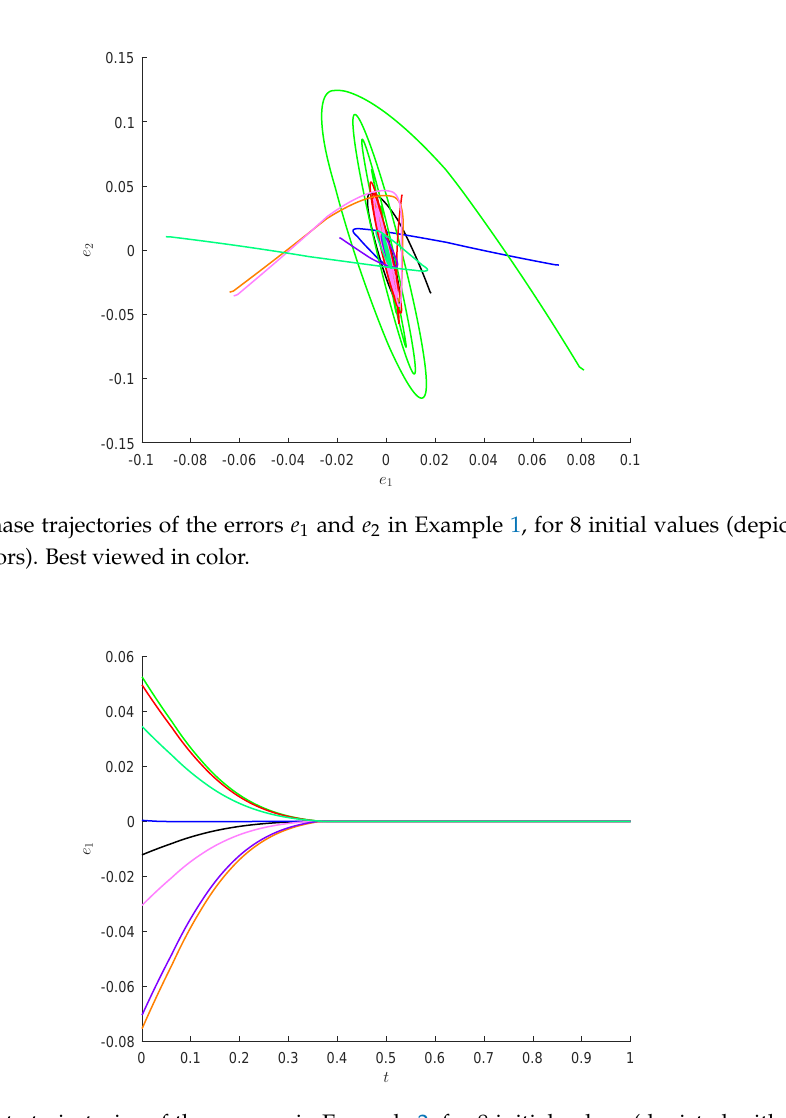
Figure 2. State trajectories of the error e 2 in Example 1, for 8 initial values (depicted with different colors). Best viewed in color.